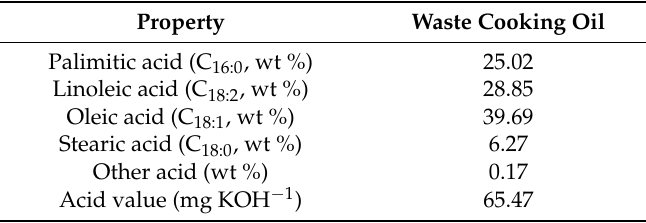
Table 4. Physical and chemical properties of waste cooking oil.